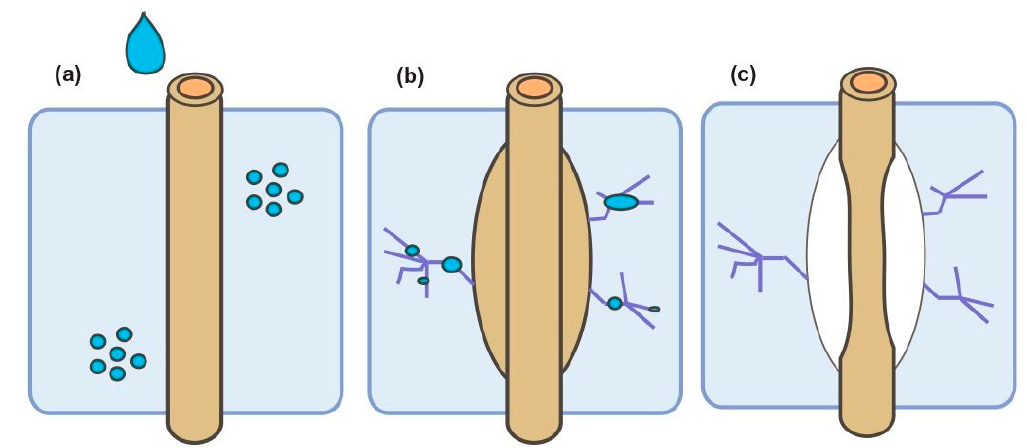
Figure 2. Effect of water at the plant fiber–matrix interface. ( a ) Water diffusion into the composite; ( b ) swelling of fibers after moisture adsorption leading to microcracks within the matrix; ( c ) ultimate fiber–matrix debonding. Based on reference [53].